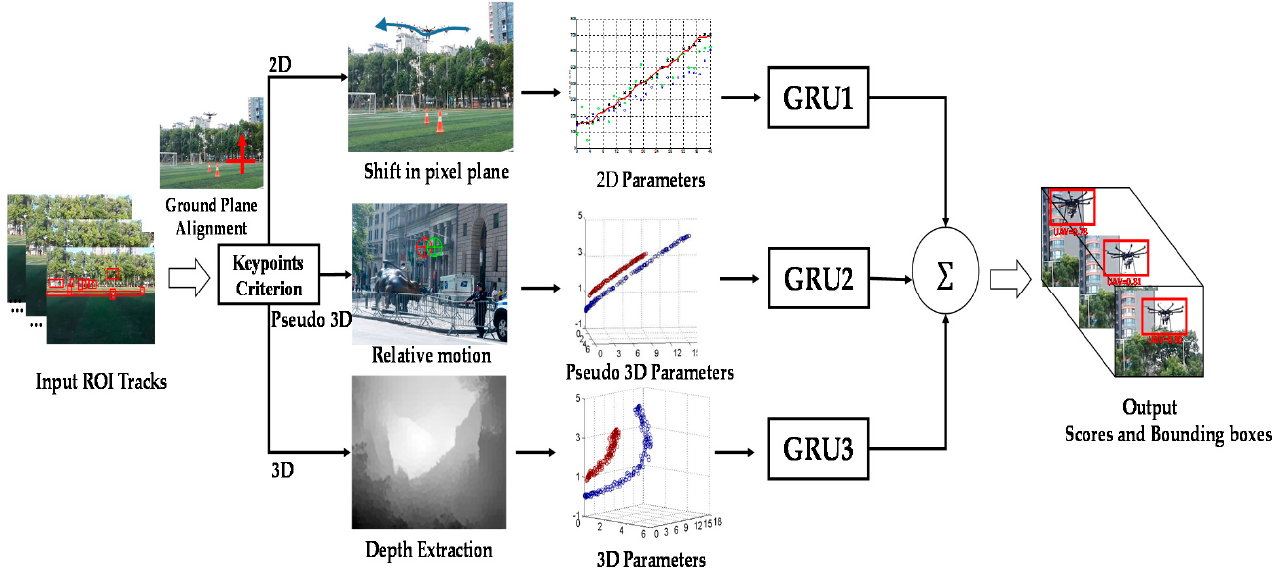
Figure 1. Pipeline of the MUSAK